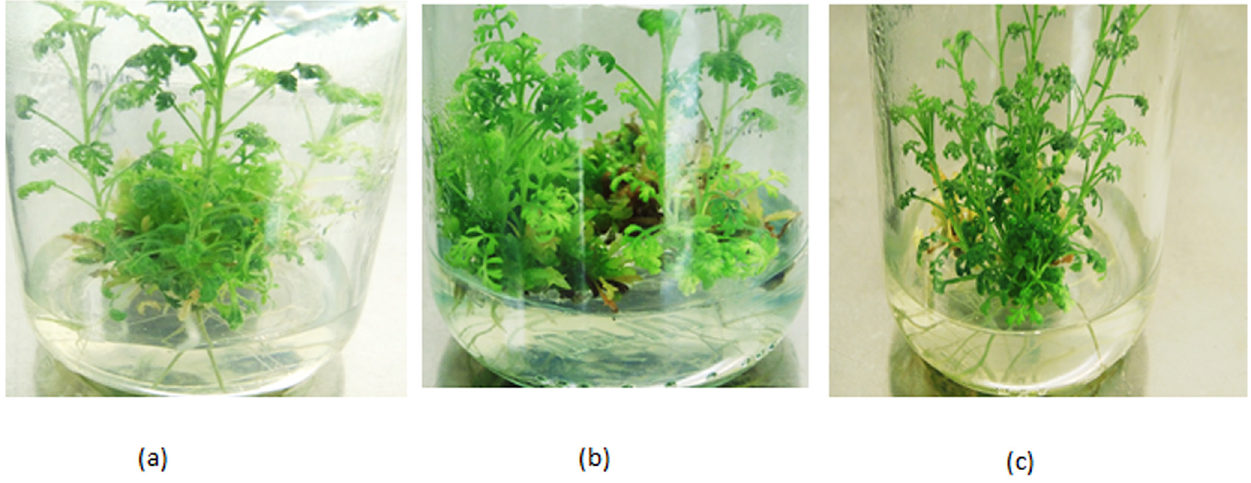
Fig 5. Vegetative propagation of A . carvifolia . A . carvifolia : wild type (a), tranformant of rol B (b), and transformant of rol C gene